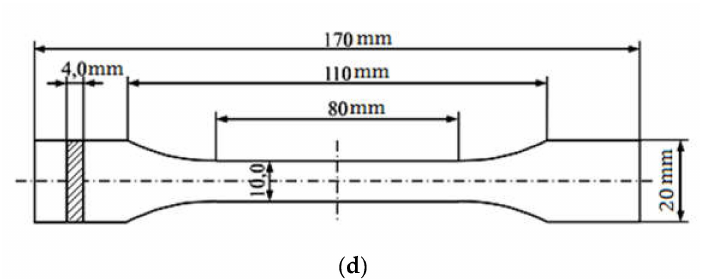
Figure 2. Geometrical dimensions and internal features of the sample. ( a ) 3D printing of bronze polylactic acid (Br-PLA) samples, ( b ) 3D printed samples, ( c ) 3D printing of polylactic acid (PLA) samples [18], ( d ) dimensions of the tensile test sample according to ISO 527-2.